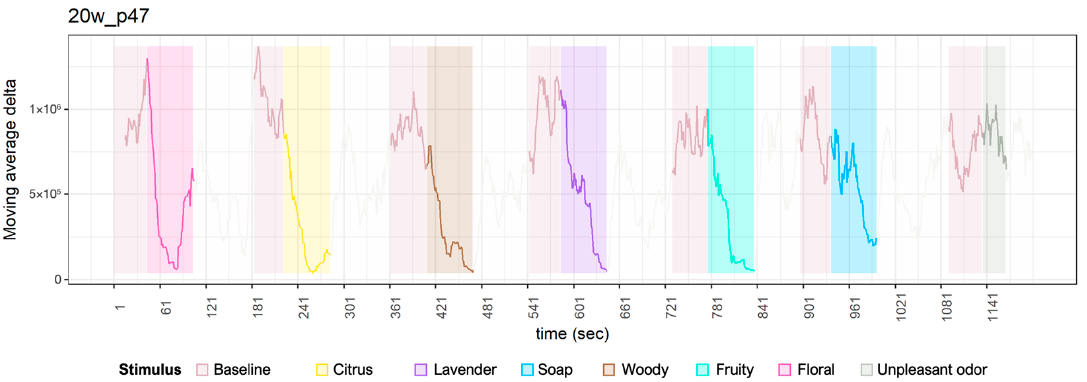
Figure A3. Time series plot of delta wave of one participant from the female 20s–30s group. The lines indicate the moving average values of delta wave Y -axis) against the time ( X -axis) from the beginning to the end of the experiment. Di ff erent colors indicates di ff erent experiment conditions (olfactory stimuli or resting as baseline).